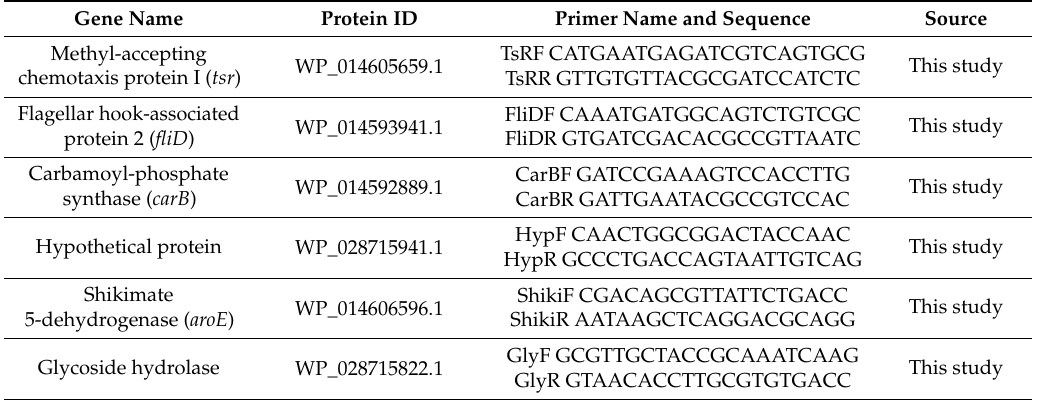
Table 2. Primers used for quantitative reverse transcription polymerase chain reaction